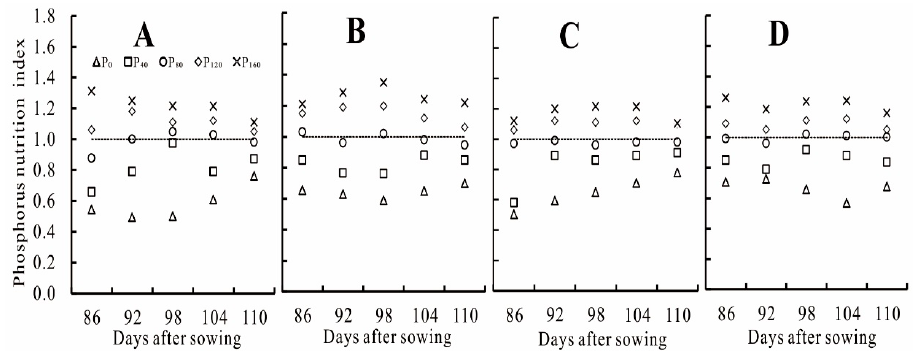
Figure 7. Phosphorus nutrition index (PNI) of two flax cultivars with five P rates in two years. ( A ) Lonyaza 1 in 2018; ( B ) Longya 14 in 2018; ( C ) Lonyaza 1 in 2019 and ( D ) Longya 14 in 2019, respectively. The reference line at PNI = 1 represents optimal P nutrition, while PNI > 1 shows excess P fertilizer application, and PNI < 1 shows P deficiency.